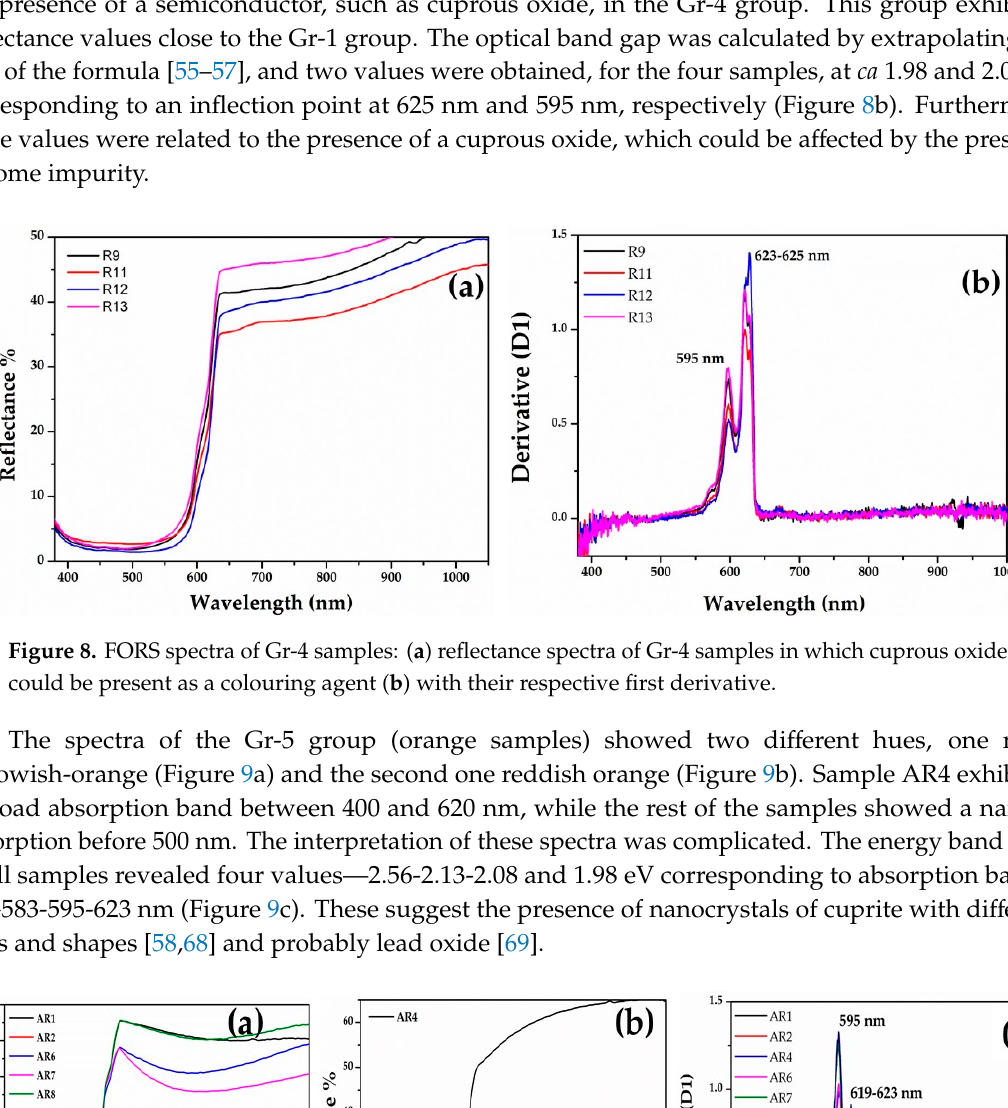
Figure 7 . Reflectance spectra of Gr-3 groups with red ( a ) and dark transparent ( c ) layer. The first derivative of the red ( b ) and dark transparent layers ( d ).